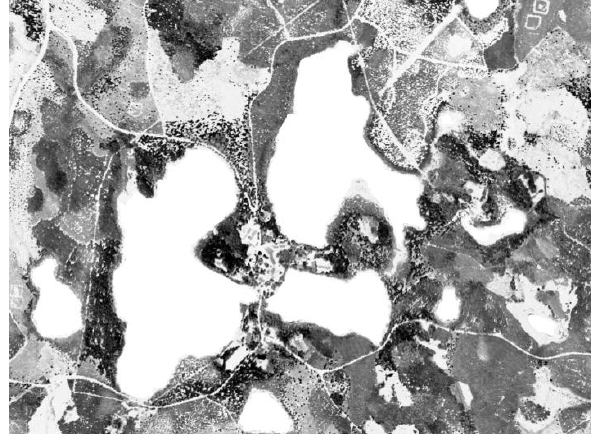
Figure 3. Canopy height model (1 m resolution) derived from airborne stereo imagery.